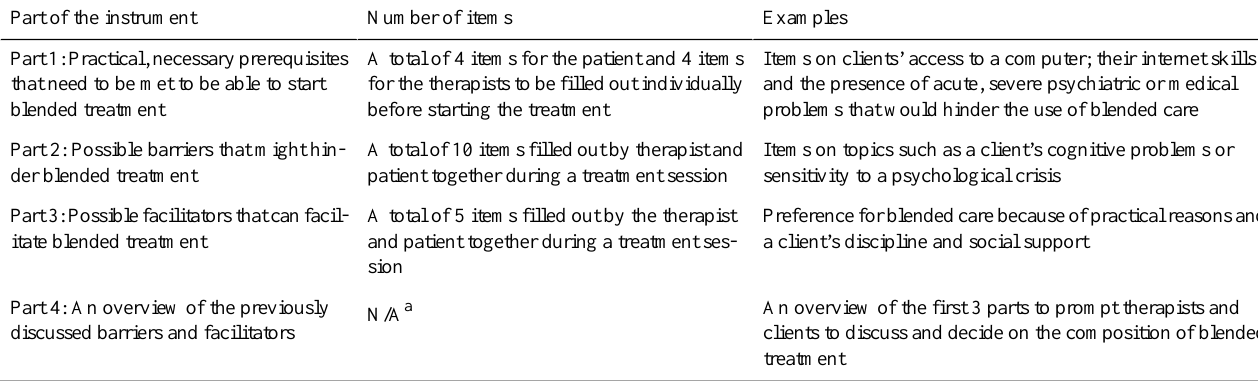
Table 1. A brief description of the 4 parts of the Fit for Blended Care